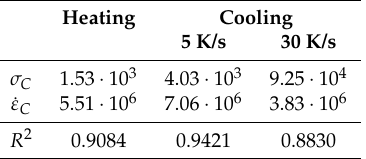
Table 3. Correlation of the experimental data and fitted model.